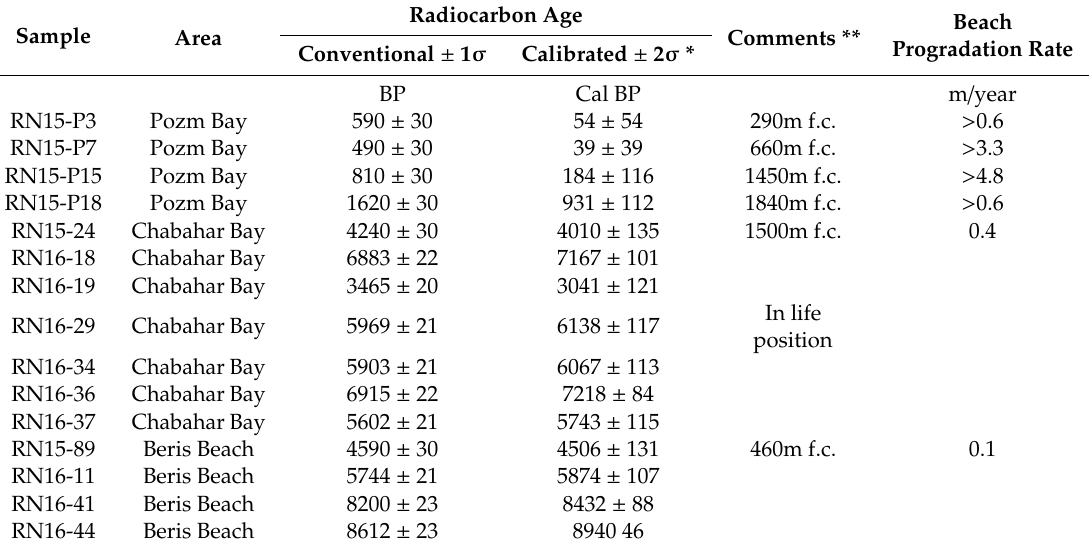
Figure 3. Satellite images of the studied beaches and localization of sampled material and measured logs. Legend: Blue star: OSL sample. Purple star: radiocarbon sample, white circles: stratigraphic logs positions, red lines: paleocli ff of the mid-Holocene maximum transgression. ( A ) Beris Beach. Image from Google Earth ( B ) Pozm Bay. Image from Bing satellite. ( C ) Chabahar Bay. Image from Google Earth. Table 1. Result of radiometric dating. Geolocalisation and more analytical details are in the data repository